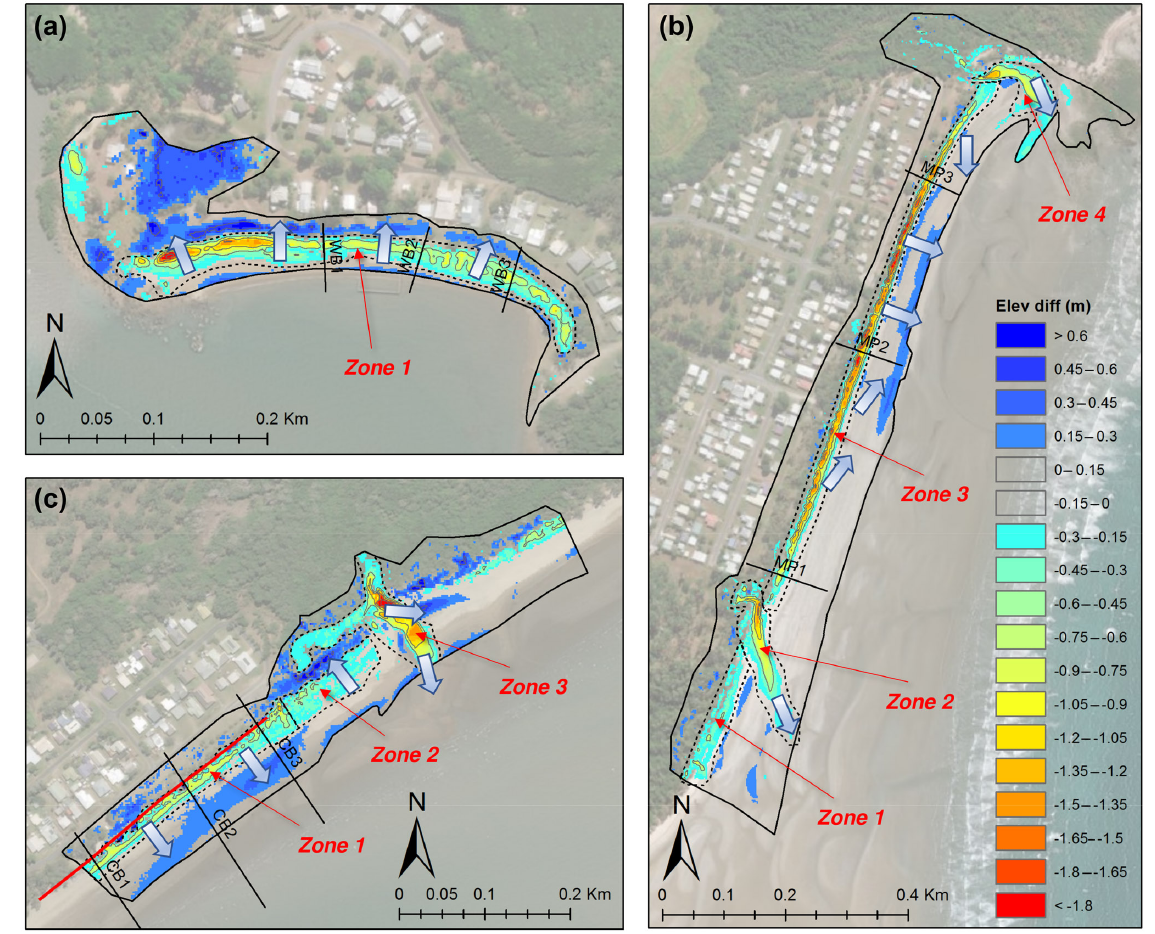
Figure 7. Coastal erosion, deposition and inferred transport pathways during Debbie at (a) Wilson Beach, (b) Conway Beach and (c) Midgeton Beach. Elevation difference plots show changes in metres (pre- Debbie minus post- Debbie ), with ± 0 . 15m (reported vertical error of lidar) not shown. Contours at 1.5, 1.0, 0.5, − 0 . 5, − 1, − 1 . 5 and − 2 . 0 are overlaid (grey lines). The approximate position of the rock revetment at Conway Beach is shown in (b) (red line). Also shown are locations of cross-shore beach profiles at each site, extents of Fugro Roames lidar data used (black box), and erosion zones referred to in the text (dashed